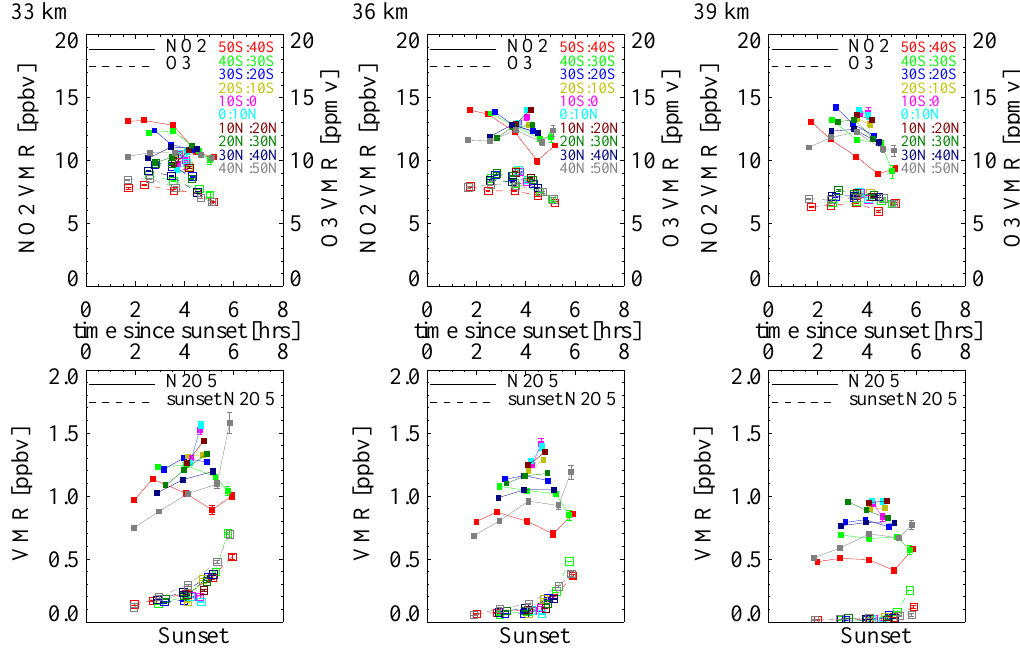
Fig. 3. Top panel shows the measured nighttime concentrations of NO 2 and ozone binned by hour since sunset in 10 ◦ latitude bands where 50–40 ◦ S is shown in red, 40–30 ◦ S in light green, 30–20 ◦ S in dark blue, 20–10 ◦ S in yellow, 10–0 ◦ S in pink, 0–10 ◦ N in light blue, 10–20 ◦ N in maroon, 20–30 ◦ N in dark green, 30–40 ◦ N in navy blue, and 40–50 ◦ N in grey. In the bottom panel, latitude bands are coloured as in top panel. The filled squares show the measured nighttime concentrations of N 2 O 5 at the given time since sunset (upper axis) for the given bin. The empty squares show the N 2 O 5 concentration at sunset (lower axis) modelled using the TUV for the given latitude bin. Error bars indicate error in mean.